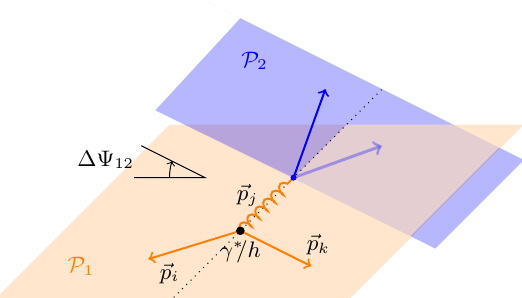
Figure 12. An illustration of the spin-sensitive observable ∆Ψ 12 as the difference of the azimuthal angles of the branching plane of the matched emission P and the branching plane of a subsequent 1 collinear branching P 2